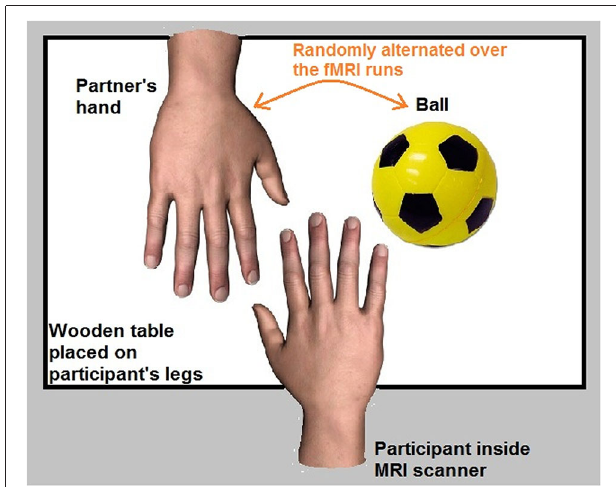
FIGURE 1 | Experimental